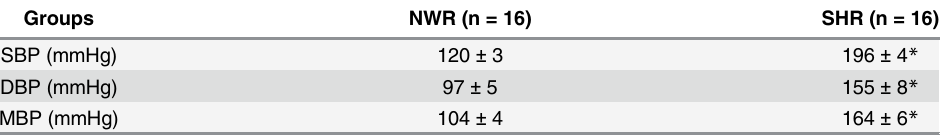
Table 1. Systolic, diastolic and mean arterial blood pressure in the NWR and SHR groups.